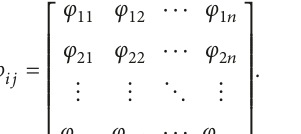
Figure 1: AHP calculation